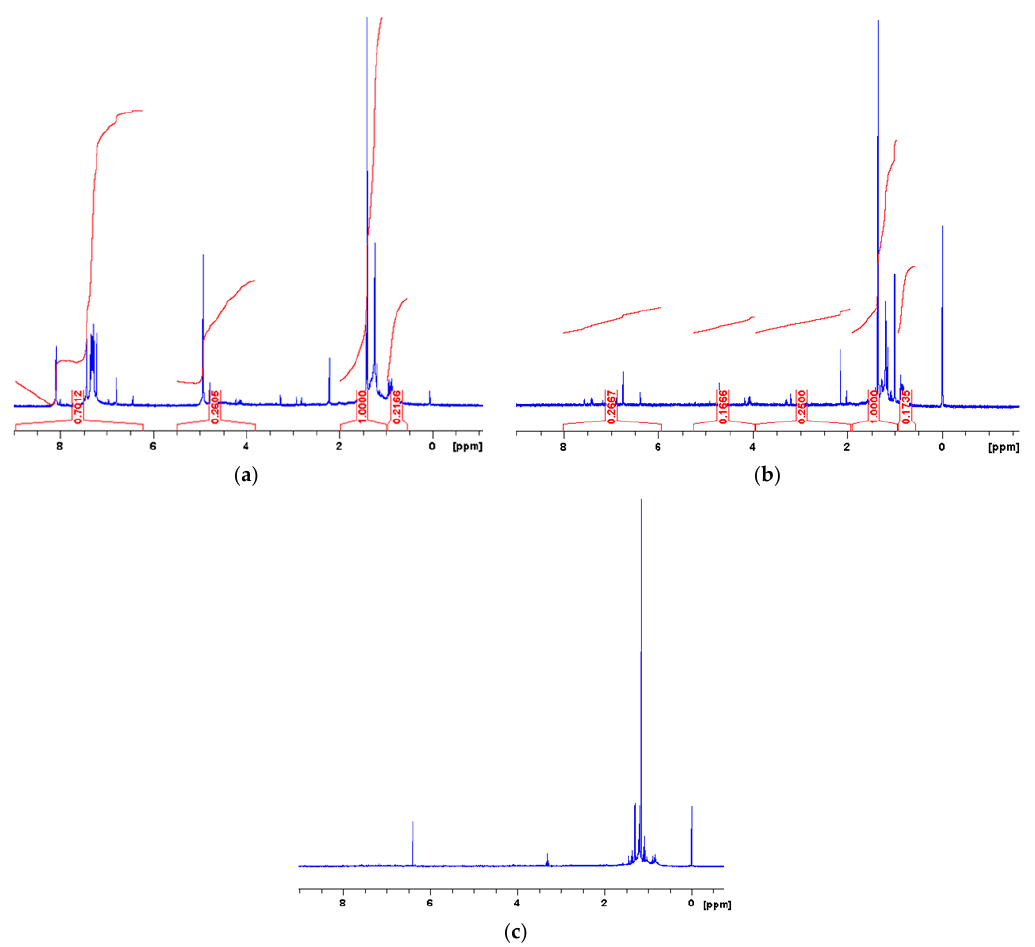
Figure 8. The 1 H-NMR spectra of zone B obtained through a preparative TLC for the three bitumens: